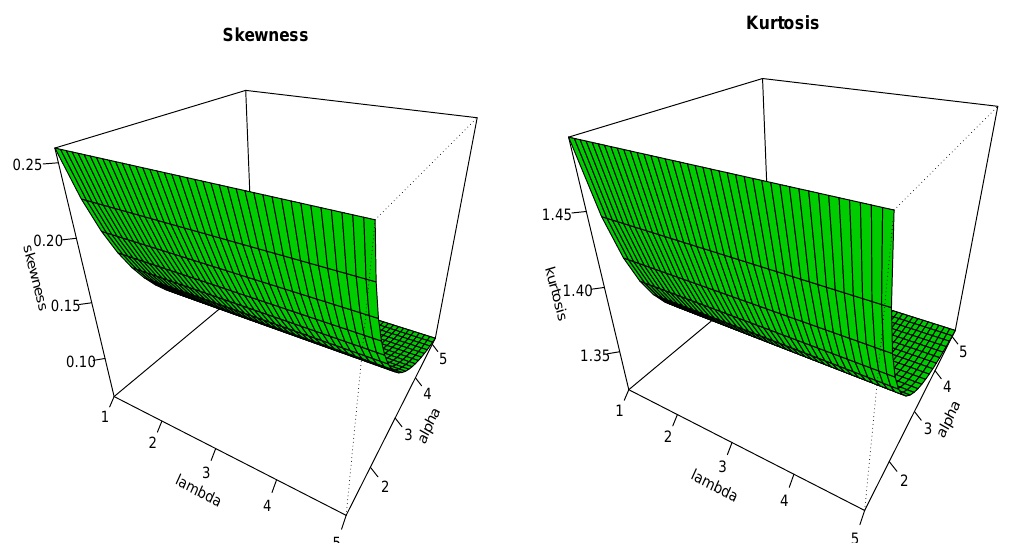
Figure 3. Shapes of the skewness and kurtosis of the IPLE distribution for different values of α and λ with β =